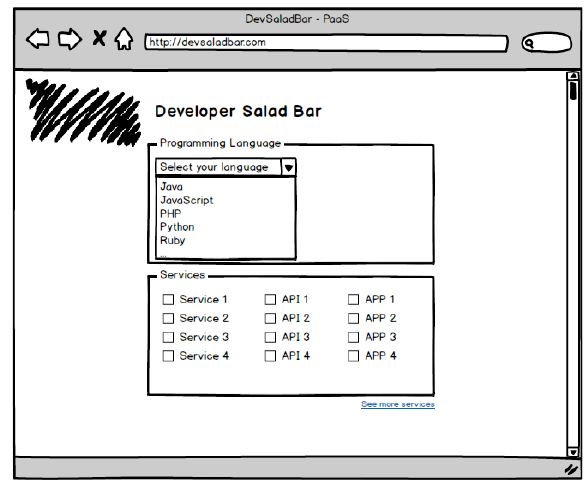
Fig. 5. . DSB's administration interface.